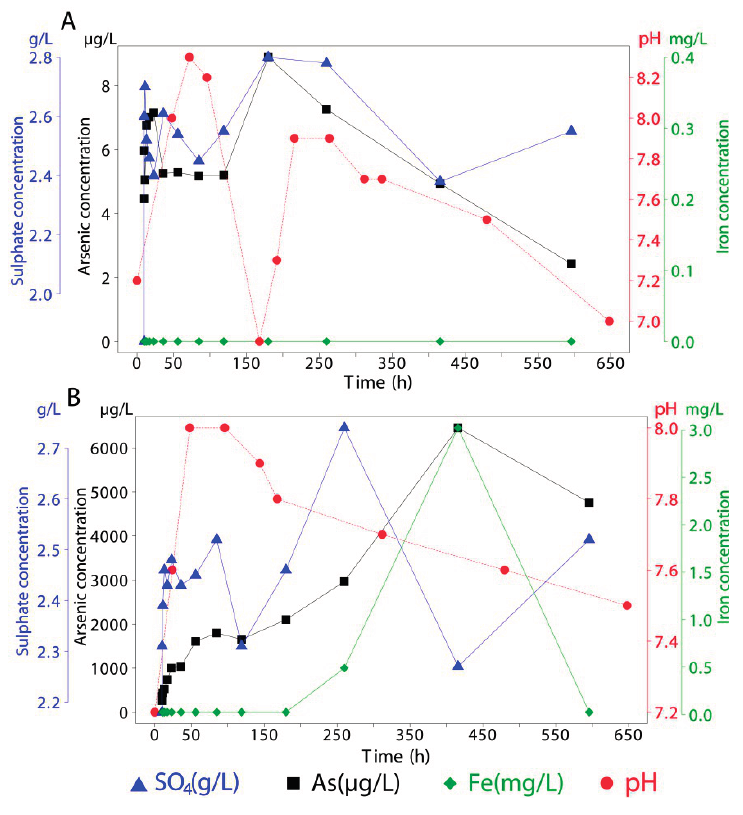
Figure 7. Arsenic release test for jarosite. ( A ) Arsenic release from co-precipitated jarosite and ( B ) arsenic release from adsorbed